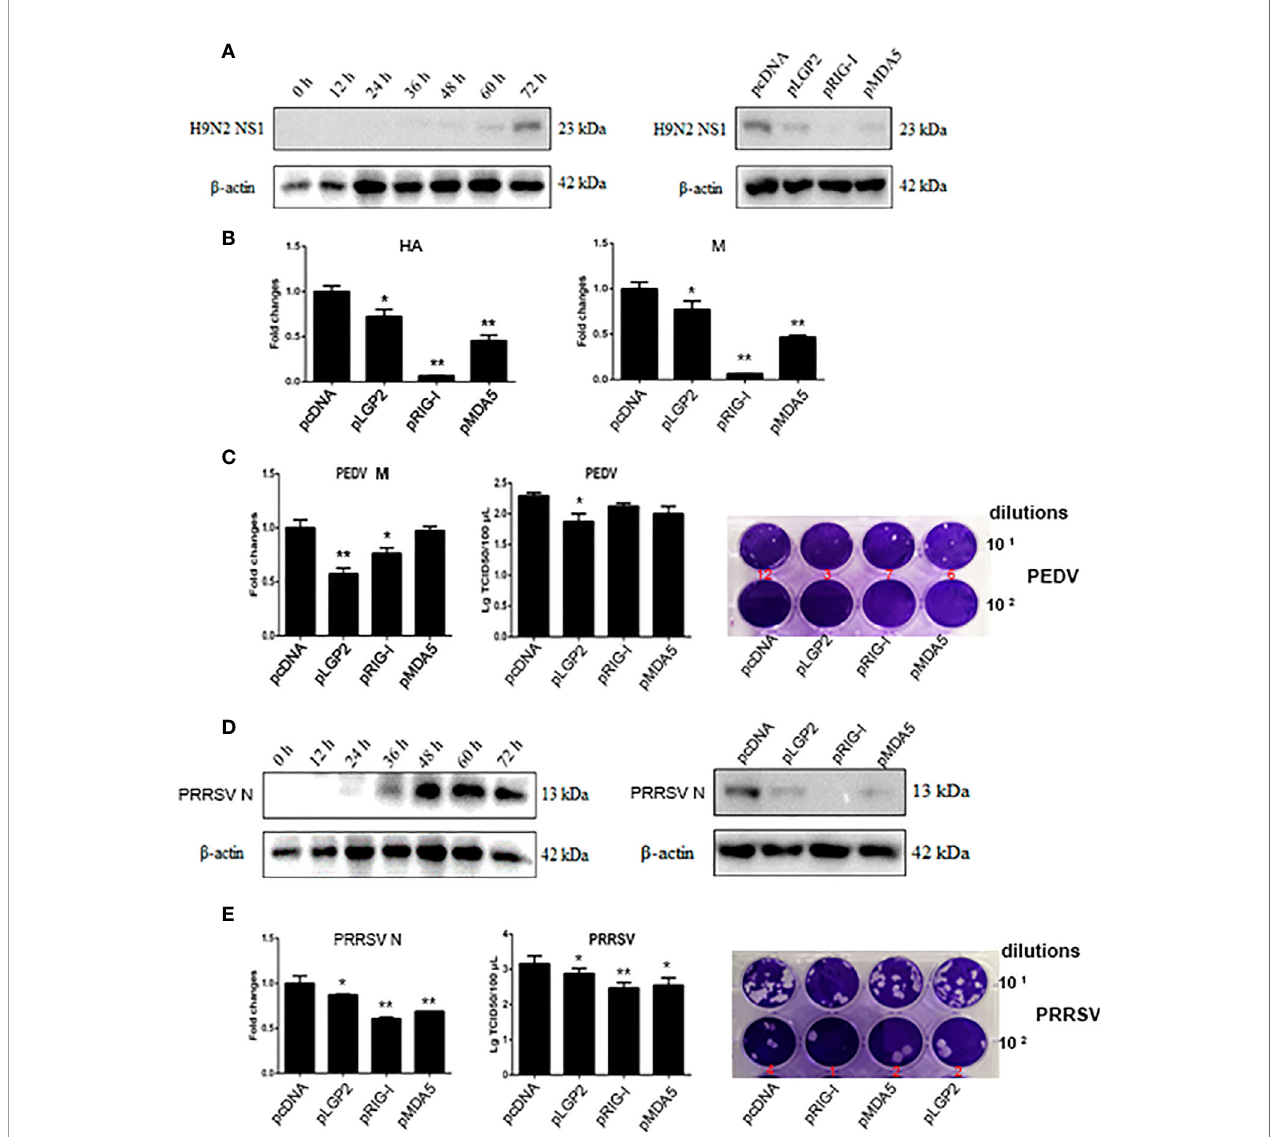
FIGURE 6 | The antiviral effects of ectopic porcine LGP2, RIG-I and MDA5. (A, B) PAMs were infected with swine in fl uenza virus H9N2 at MOI of 0.01 for different hours and the viral protein NS1 was detected by Western-blotting with anti-NS1 mAb (left panel, A ). PAMs grown in 12-well plates (5×10 5 cells/well) were transfected with LGP2, RIG-I and MDA5 (1 m g each) using TransIT-LT1 Transfection Reagent. The cells were infected with 0.01 MOI H9N2 for further 63 h and analyzed by Western-blotting for NS1 protein expression (right panel, A ) and RT-qPCR for viral HA and M gene expressions (B) . (C) IPEC-J2 cells grown in 12-well plates (5×10 5 cells/well) were transfected as in (A) and infected with 0.01 MOI PEDV (YC2014 strain) for 24 h. The cells were analyzed by RT-qPCR for viral M gene expression (left). The cell supernatants were examined by TCID50 assay (middle) and plaque assay (right), which were performed with Vero cells for 6 day infection and the countable plaque numbers are labeled in red color below the wells of plate. (D, E) Marc-145 cells were infected with 0.01 MOI PRRSV (JXA1-R strain) for different hours and the virus protein N was detected by Western-blotting with anti-N mAb (left panel, D ). Marc-145 cells grown in 12-well plates (5×10 5 cells/well) were transfected as in (A) , and the cells were infected with 0.01 MOI JXA1-R for 36h and analyzed by Western-blotting for N protein expression (right panel, D ) and RT-qPCR for viral N gene (left, E ). The cell supernatants were examined by TCID50 assay (middle, E ) and plaque assay (right, E ), which were performed with Marc- 145 cells for 6 day infection and the countable plaque numbers are labeled in red color below the wells of plate * p < 0.05, ** p < 0.01 vs pcDNA